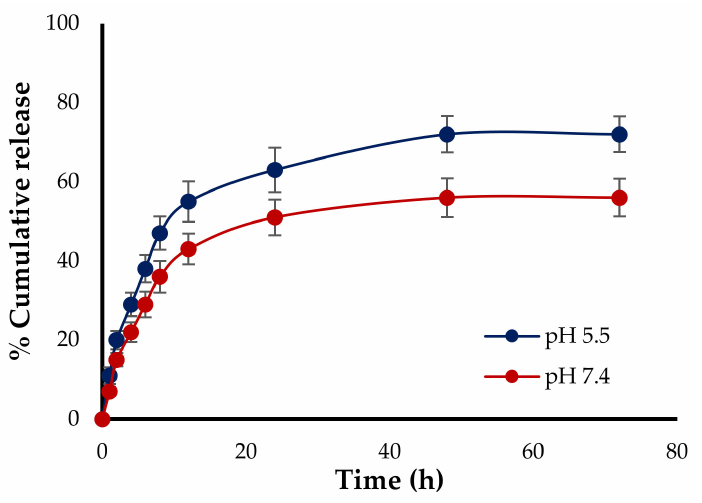
Figure 3. In vitro release study of DXL from SF-NPs in phosphate-buffered saline (pH 5.5 and